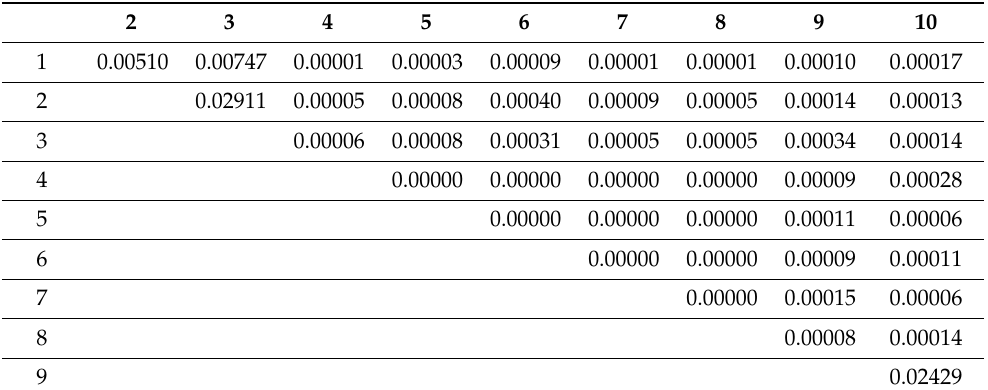
Table 6. Mean squared error of interaction coefficient estimates for MLEFM2 ( N = 1000).